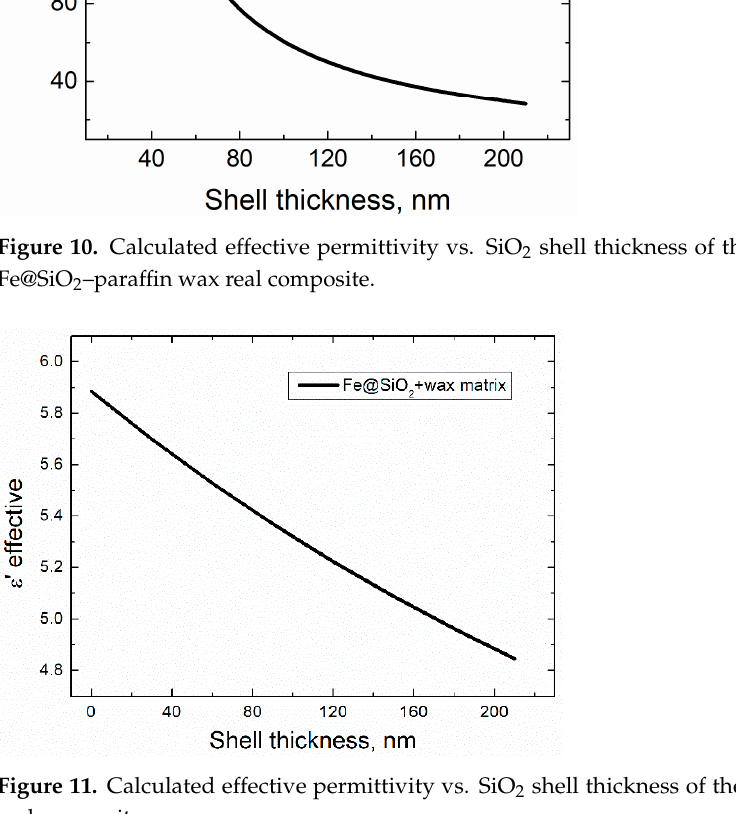
Figure 11. Calculated effective permittivity vs. SiO 2 shell thickness of the Fe@SiO 2 –paraffin wax real composite.